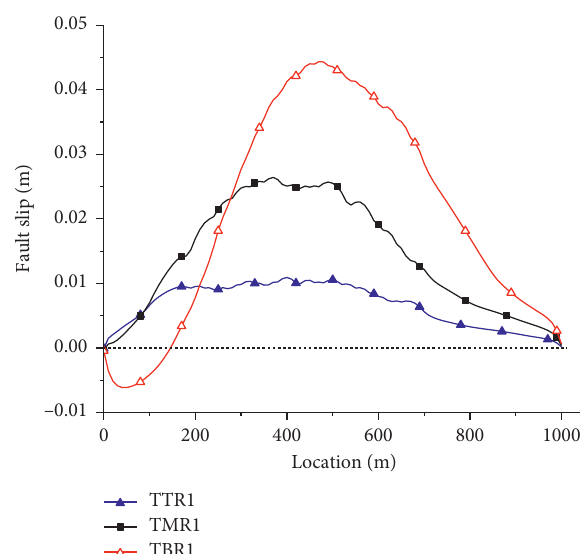
Figure 8: Fault slip along the fault plane when the fracturing region was TTR1, or TMR1, or